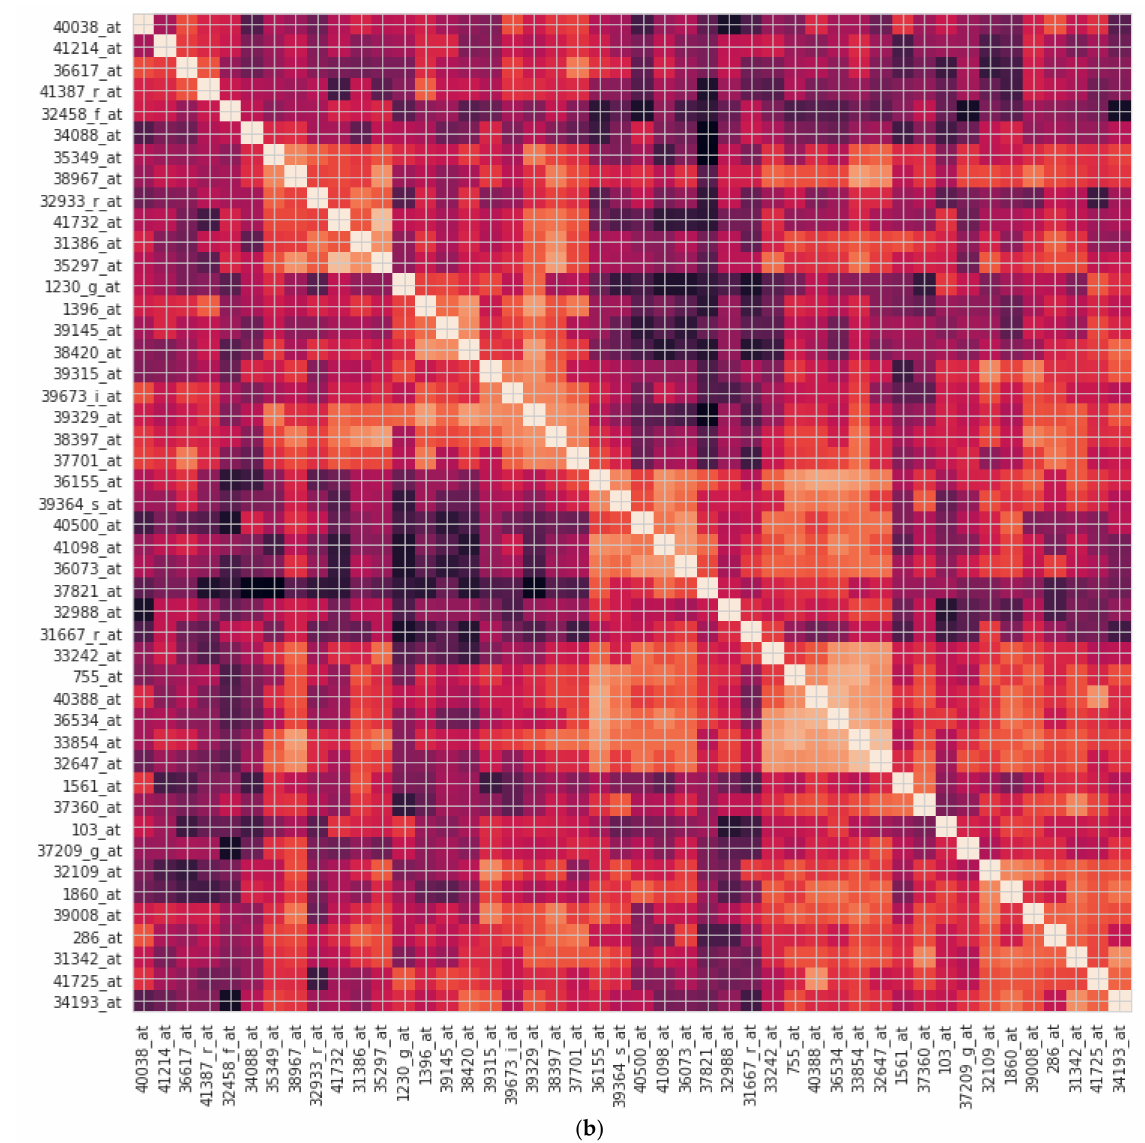
Figure 11. ( a ) Hierarchical clustering dendrogram maps of the genes selected in the proposed hybrid model. ( b ) Heat maps of the genes selected in the proposed hybrid